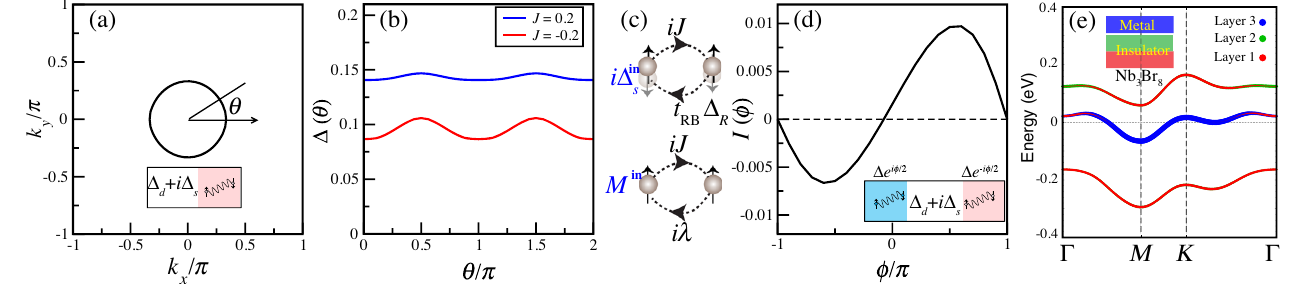
FIG. 7. (a) Fermi surface for TB with Δ d þ i Δ s pairing. The inset illustrates the proximity process leading to the pairing amplitude in (b). (b) Spin-singlet pairing strengths along each FS for J ¼ (cid:4) 0 . 2 . θ is the angle along each FS as defined in (a). (c) Perturbation process for pairing and magnetism, respectively. In the top panel, a current term iJf i c † j , a pairing term c † j σ c † j ¯ σ followed by t pairing. In the bottom panel, a current term iJf i c † j following SOC i λ c j σ z f † i induces spin polarized M in σ z . (d) The Josephson currents þ i Δ I ð ϕ Þ in unit of 2 e= ℏ for the Δ d s JD. The other parameters are set as t ¼ 0 . 8 , t ¼ 0 . 4 , μ ¼ − 3 . 0 . In the calculation, we set the thickness of SC on both sides to be 20. (e) Band structures for Nb RB LB with wave function projections onto each layer. From wave function projection, layer 1 and layer 2 strongly couple with each other and form an insulator with band gap. Layer 3 is metallic with bandwidth 0.1